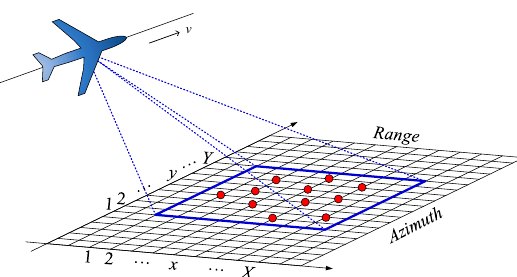
Figure 1. Diagram of a gridded synthetic aperture radar (SAR) observation model. The blue box represents the observed area. The red points represent discrete scattering points with large coefficients. X and Y are the number of grids in range and azimuth directions, respectively.